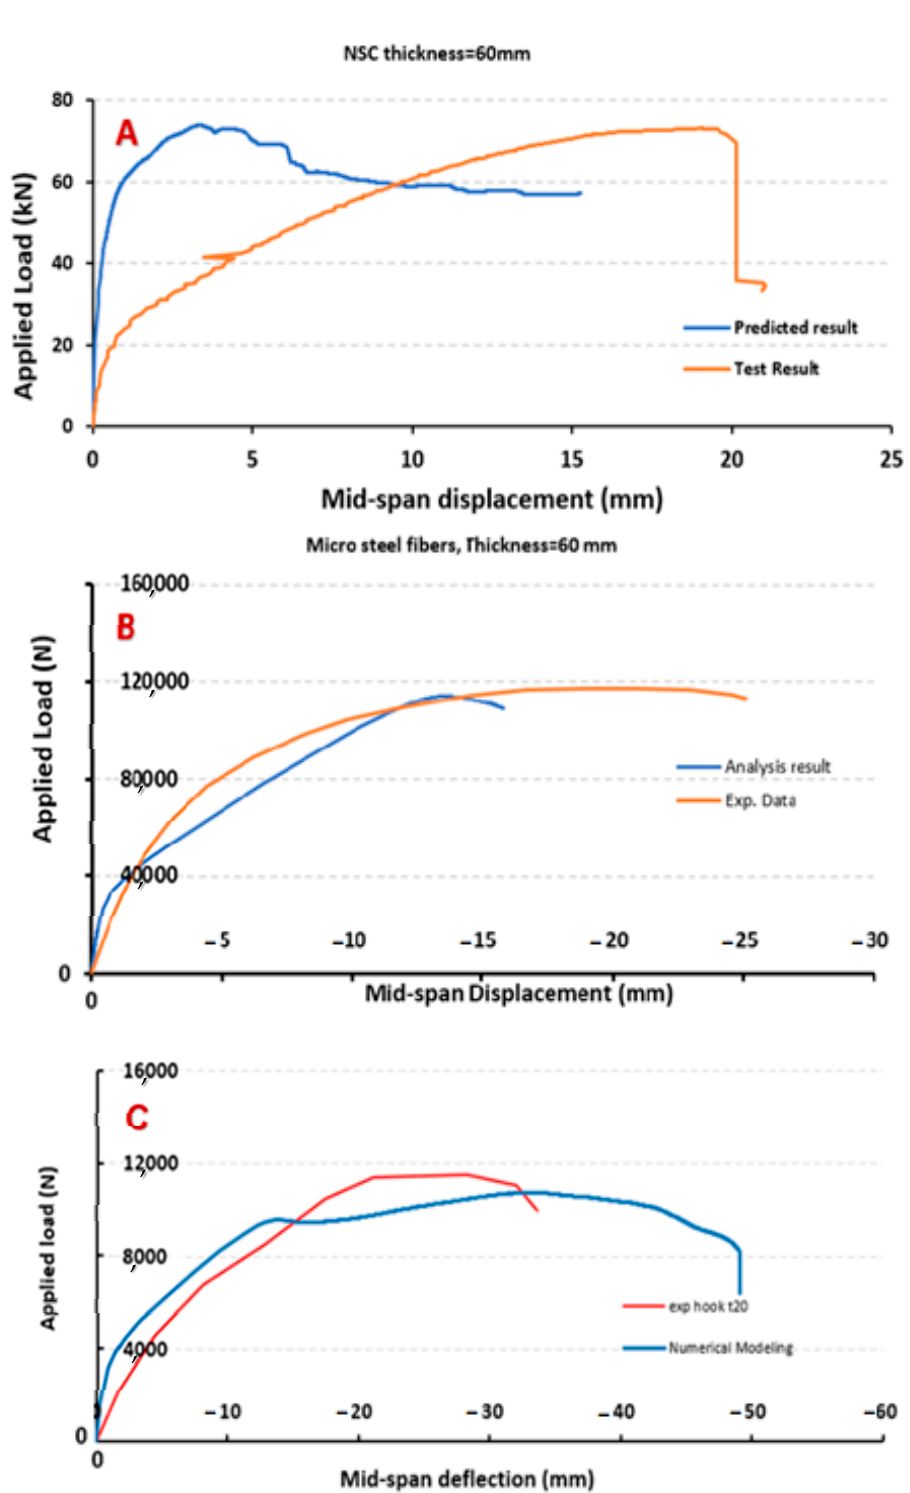
Figure 13. Experimental and numerical load-axial displacement relationship of ( A ) NSC (thickness = 60 mm), ( B ) SIFCON slabs with micro steel fibre (thickness = 60 mm), and ( C ) SIFCON slabs with micro steel fibre (thickness = 20 mm).